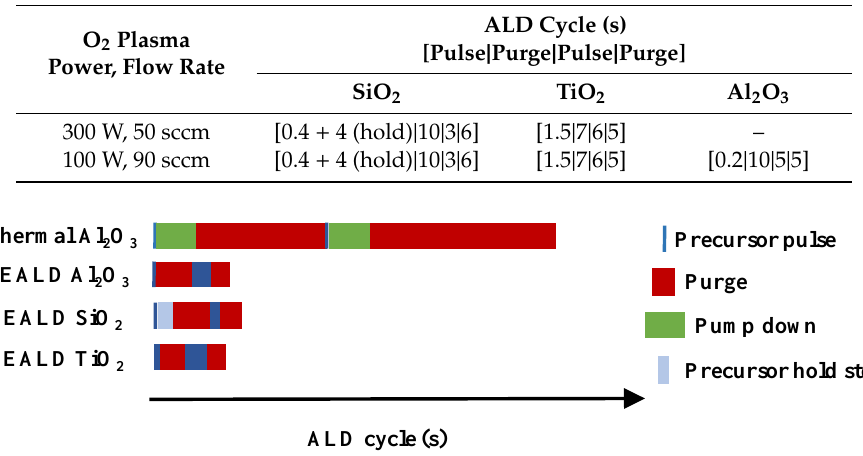
Figure 1. Schematic diagram of ALD cycle times for depositing thermal Al 2 O 3 , PEALD Al 2 O 3 , SiO 2 and TiO 2 films at 60 °C.